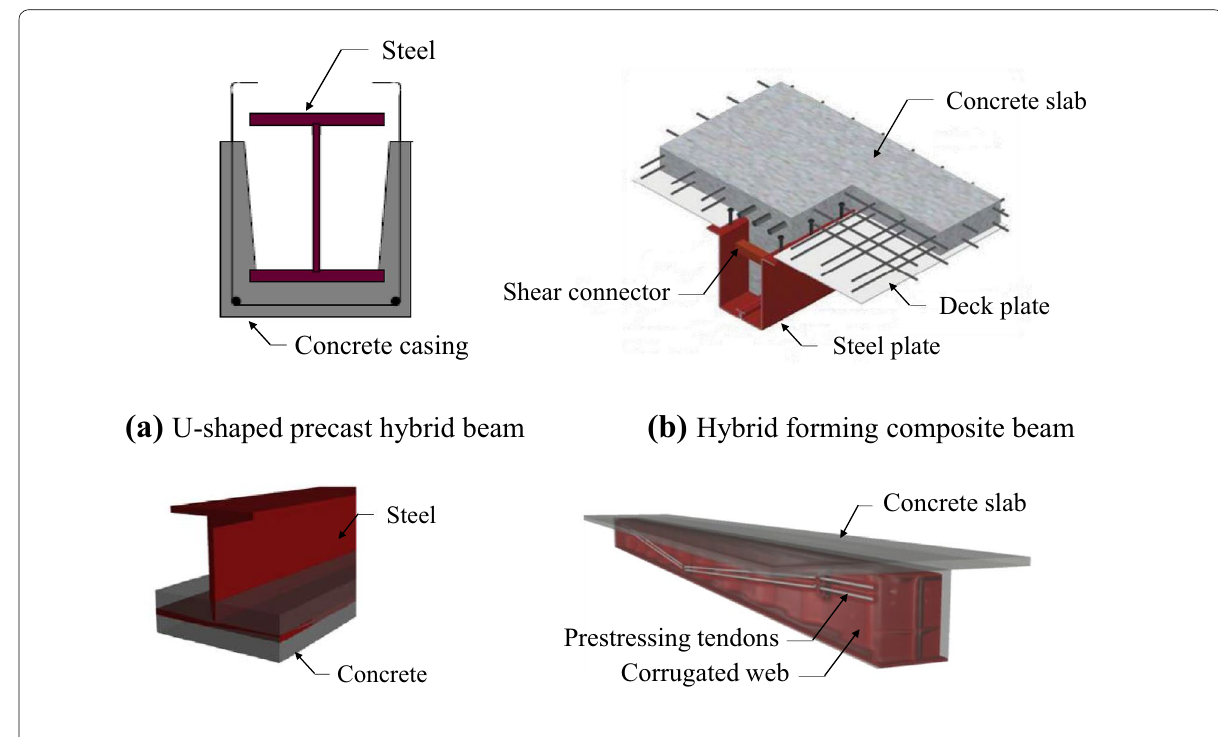
Fig. 1 Various composite structural members in